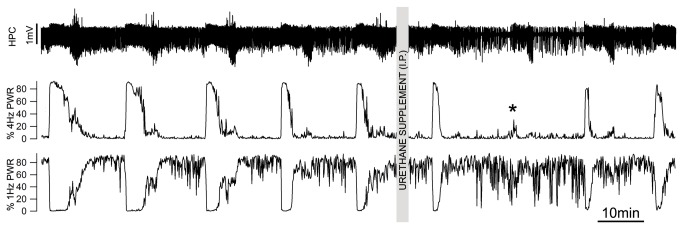
Supplemental doses of urethane anesthesia do not affect rhythmicity of brain state alternations. Long term EEG recording at the HPC site and its corresponding percentage of total power calculated in the 3-4Hz range and for 0.2-1.2Hz range during regular brain state transitions under urethane anesthesia and supplemental dose of urethane (0.02ml at 0.2 g/ml dose). Note the temporary depression of power in the theta range (asterisk) followed by the resumption of regular brain state alternations.